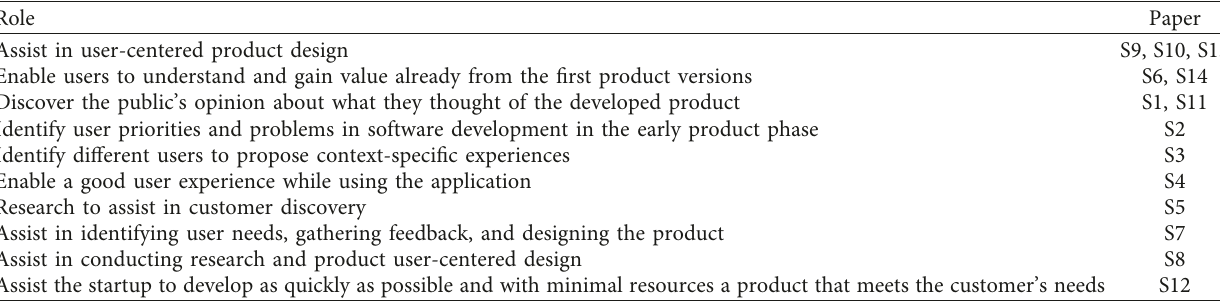
Table 6: Roles of UX identified in the extracted papers.